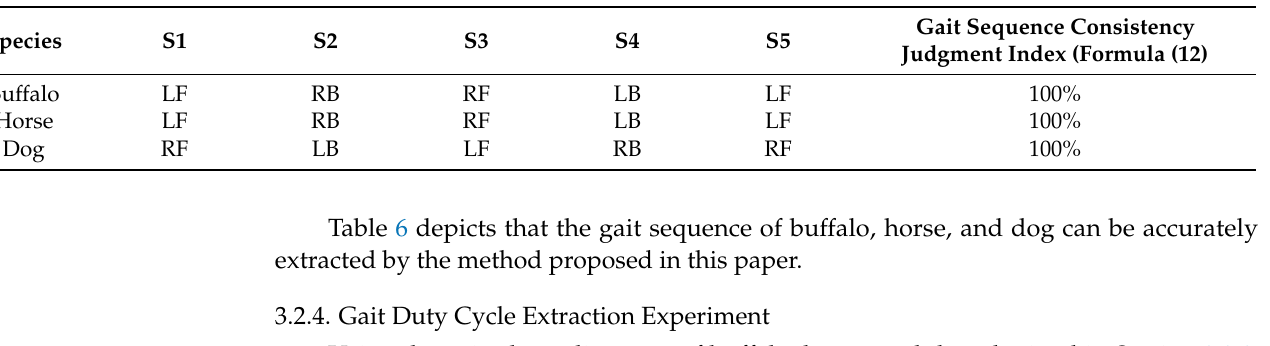
Figure 17. ( a ) Buffalo gait sequence; ( b ) horse gait sequence; ( c ) dog gait sequence. The gait sequence of buffalo, horse, and dog is shown in Table 6. Table 6. Gait sequence of buffalo, horse, and dog. Table 6. Gait sequence of buffalo, horse, and dog.